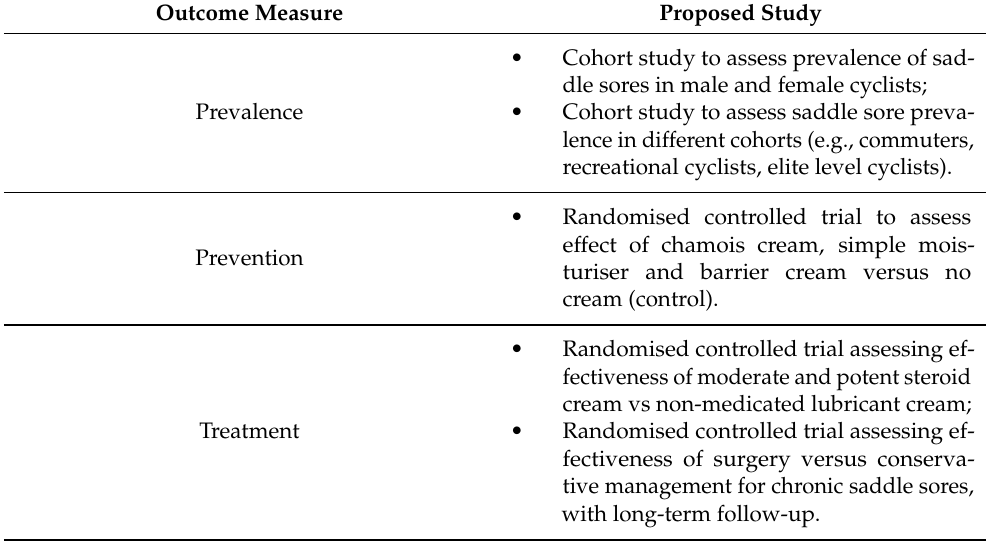
Table 2. Proposals for future saddle-sore